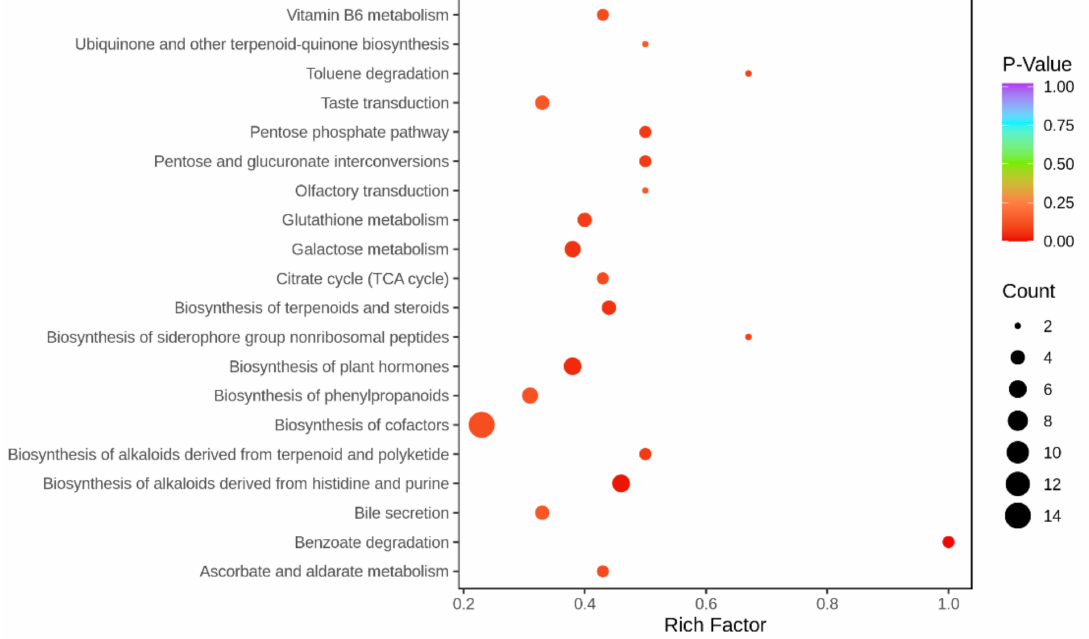
Figure 10. Differential accumulated metabolites KEGG enrichment. The size of the points in the graph represents the number of distinct significant metabolites enriched into the corresponding pathway. The more p -Value approaches to 0, the more significant the enrichment